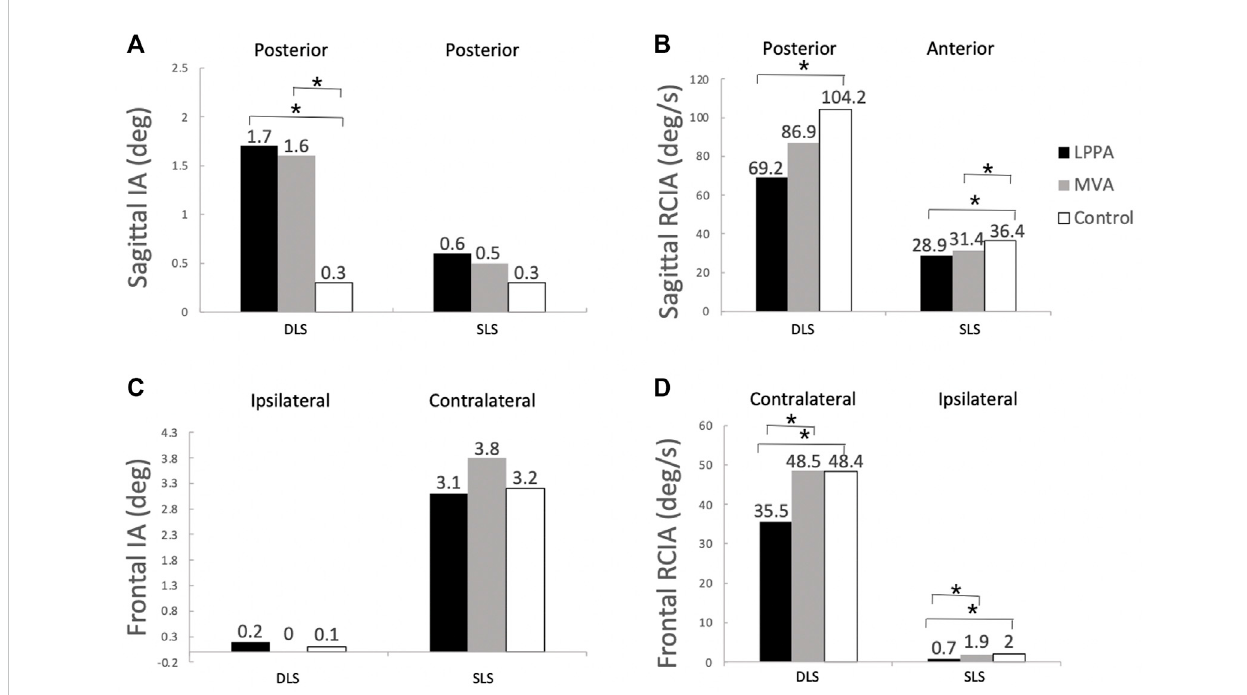
Mean values oftime-averaged COM-COP inclination angles (IA) and their rates of change (RCIA)overphases of terminal double-limb support (DLS) and single-limb support (SLS) during level walking in the sagittal (A,B) and frontal (C,D) planes for the lateral parapatellar approach (LPPA), mid-vastus approach(MVA),andthecontrolgroups.PositivesagittalandfrontalIAindicateCOMpositionsthatareanteriorandcontralateraltotheCOP,respectively. PositivesagittalandfrontalRCIAindicateratesofanteriorchangesandcontralateralchangesinthecorrespondingIA,respectively.Asterisksindicate statistical signi fi cance ( p <